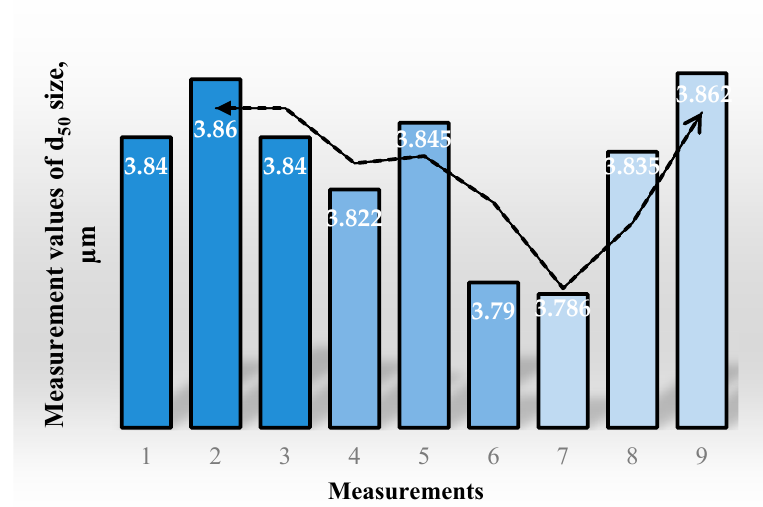
Figure 5. Statistical evaluation of measurement values of the d 50 size.